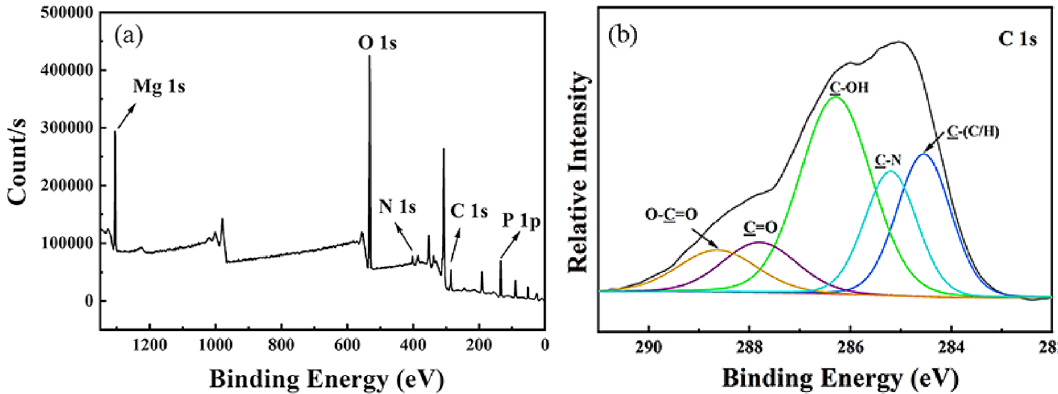
Figure 7. XPS wide survey scans ( a ) and high-resolution C 1 s ( b ) of the sample biomimetically synthesized for 30 min with the supernatant macromolecule